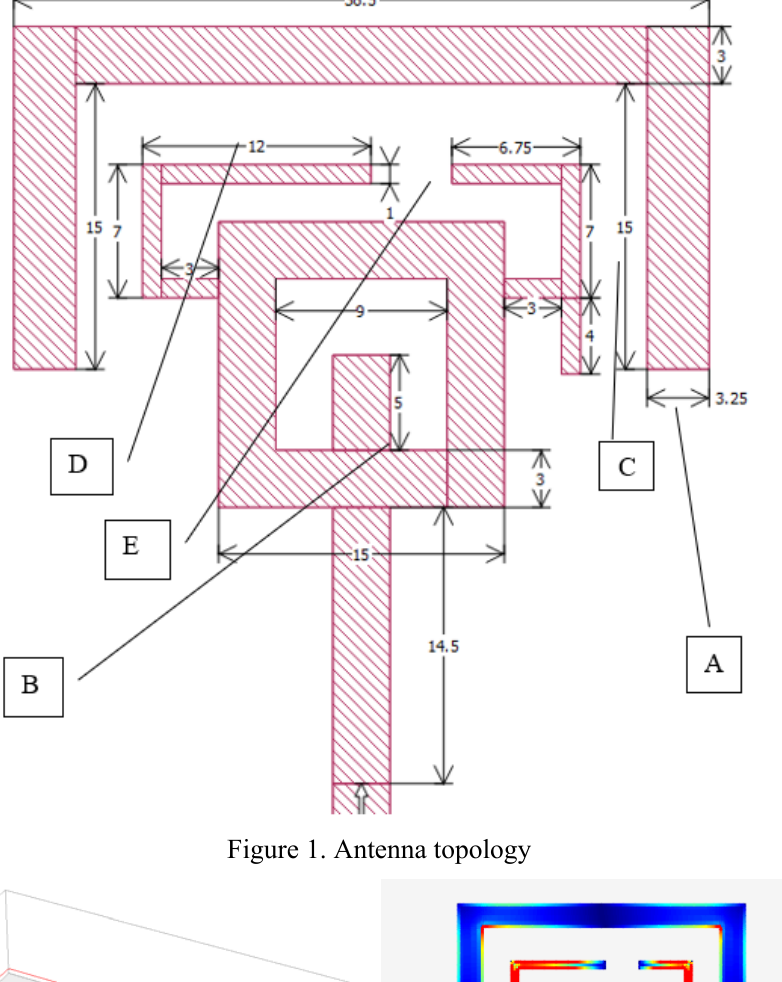
Figure 1. Antenna topology